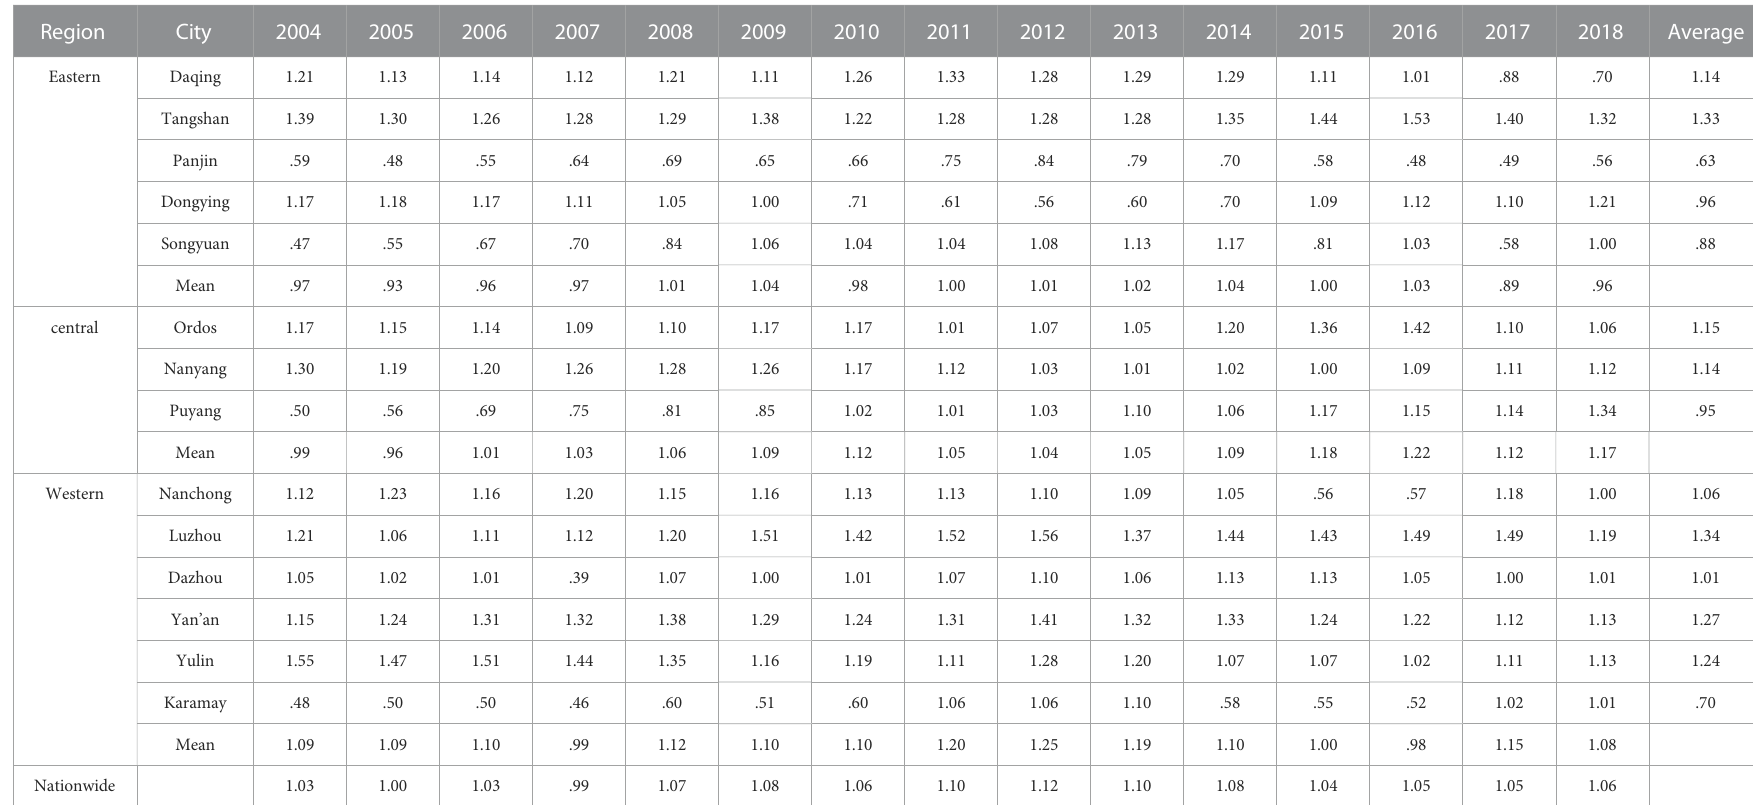
Region City 2004 2005 2006 2007 2008 2009 2010 2011 2018 Average Eastern 1.21